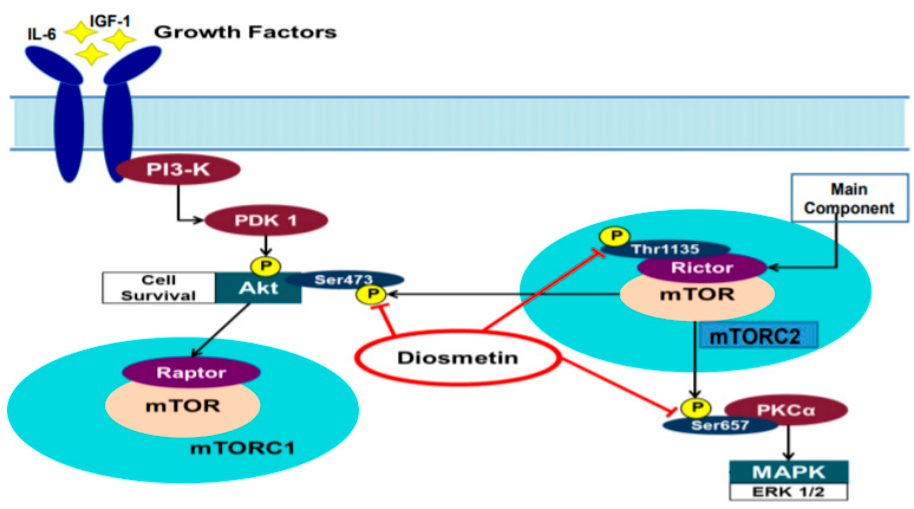
Figure 7. Schematic representation of Rictor-AKT–PKC α pathways and their interactions with each other in forming a growth promoting loop. Diosmetin was able to modulate these molecules by inhibiting their phosphorylation to inhibit the progression of prostate cancer.